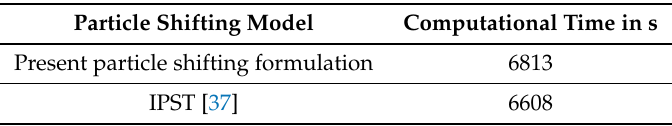
Table 1. Dam break flow: comparison table of the computational times using our present particle